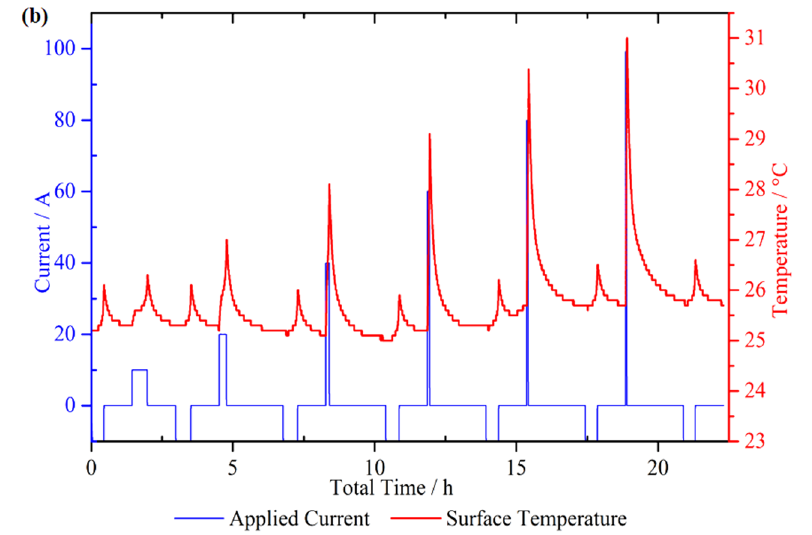
Figure 7. Thermistor (placed near the positive tab of the cell) based temperature profile (red line) of LTO cell and corresponding load profile (blue line) during ( a ) continuous charge at 10 A and discharge at 10 A, 20 A, 40 A, 60 A, 80 A and 100 A, respectively; ( b ) continuous charge at 10 A, 20 A, 40 A, 60 A, 80 A and 100 A and discharge at 10 A, respectively. Discharge is denoted by negative current.